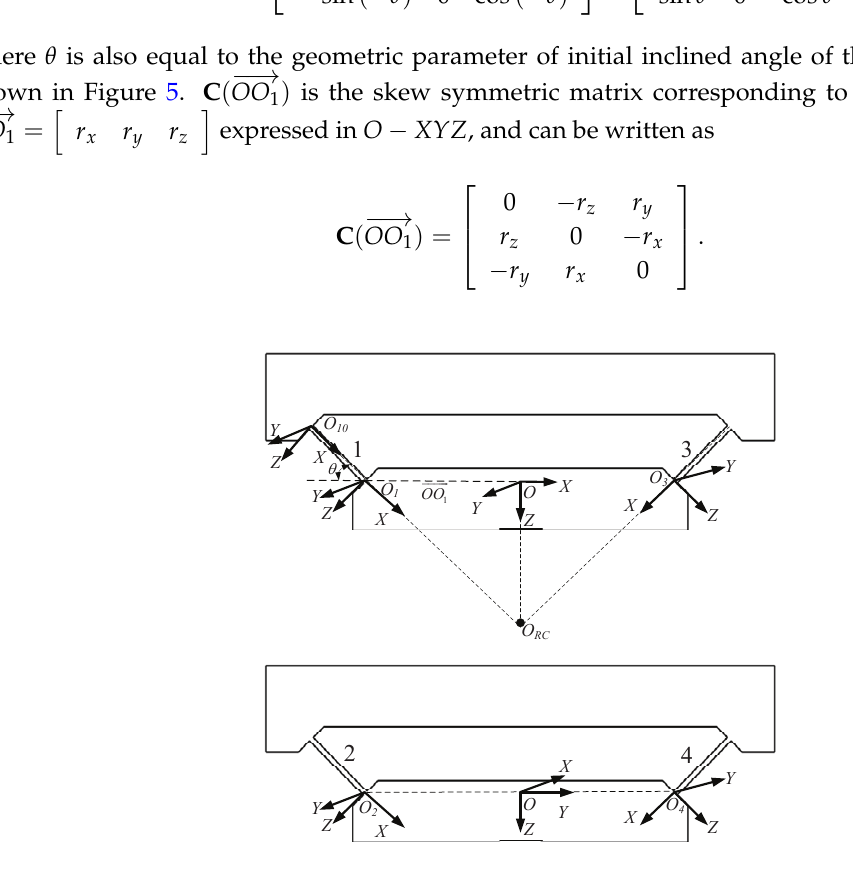
Figure 5. Coordinate system of the RCC